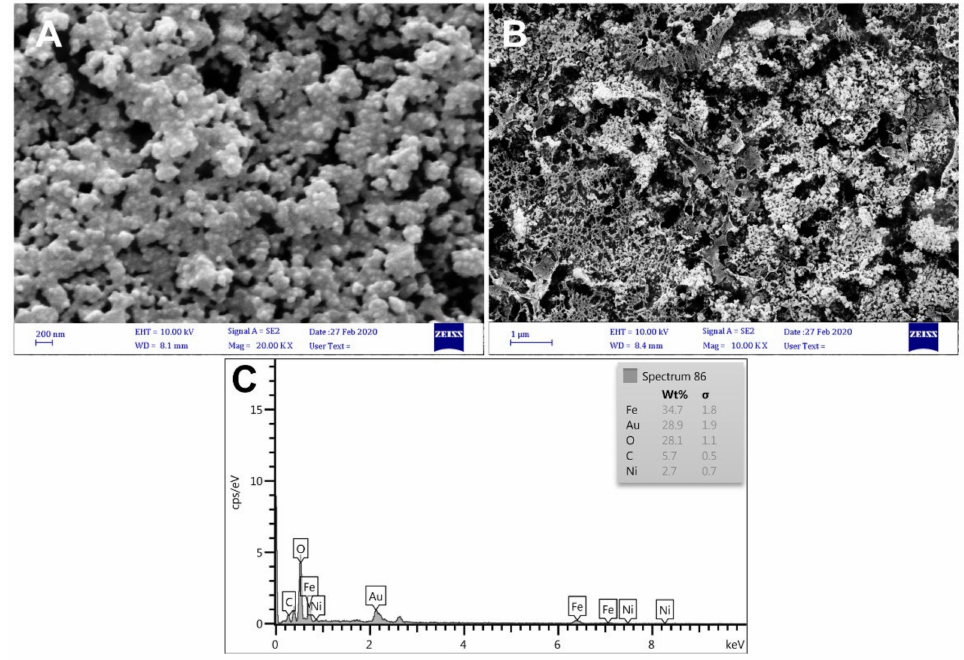
Figure 4. ( A , B ) SEM and ( C ) EDS of the GCE after modification with AuNUs/Fe-Ni@rGO.